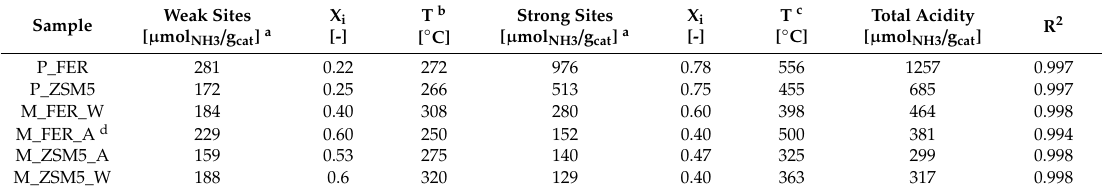
Table 3. Samples acidity via NH 3 -Temperature Programmed Desorption (NH 3 -TPD) analysis.